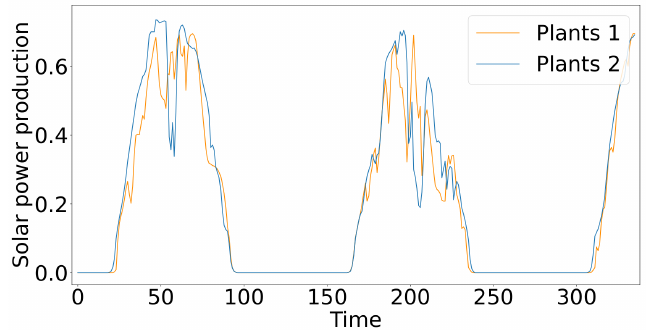
Figure 6. Solar power generation per 10 min.